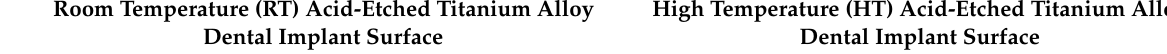
Table 4. XPS binding energies of Ti2p, Al2p, V2p, C1s, O1s, and F1s at the surface of the titanium surface etched at room temperature and high